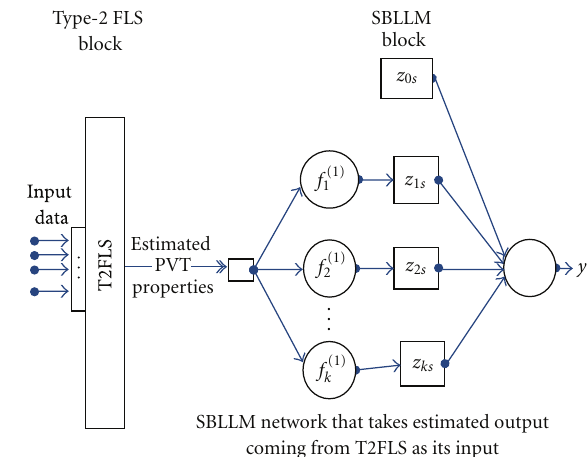
Figure 7: Network diagram of the proposed hybrid showing the flow of data from T2FLS into SBLLM for both training and testing phases ( y stands for the final PVT properties output from the hybrid